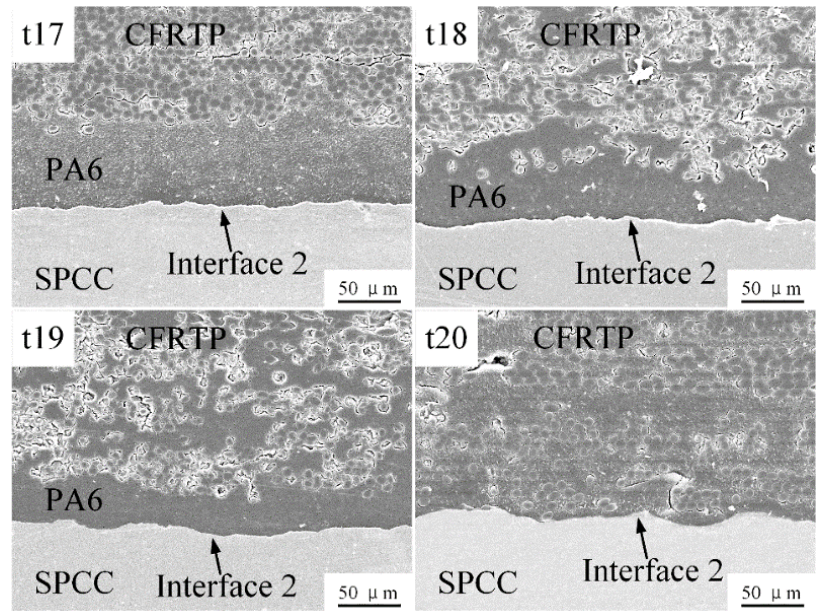
Figure 20. Microstructures of interface 2 obtained under 200 °C.